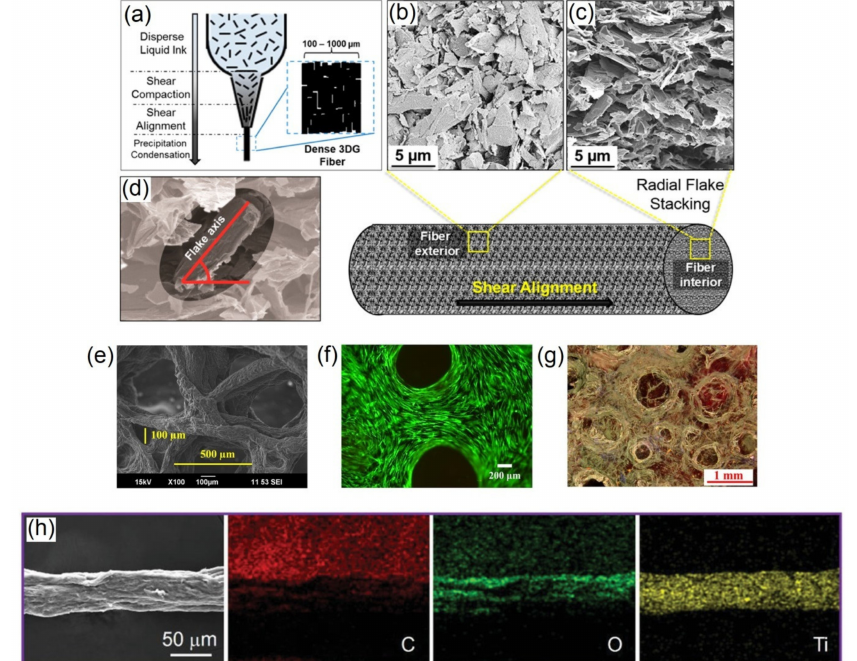
Figure 6. ( a ) Schematic of 3D printing PLG/pGn composite hydrogels showing graphene flake alignment with shear force. SEM images of the 3D printed fiber: ( b ) exterior (showing graphene flake alignment) and ( c ) cross-section (showing graphene flake stacking). ( d ) Graphene flake orientation in an end-on cross-sectional view of the 3D printed